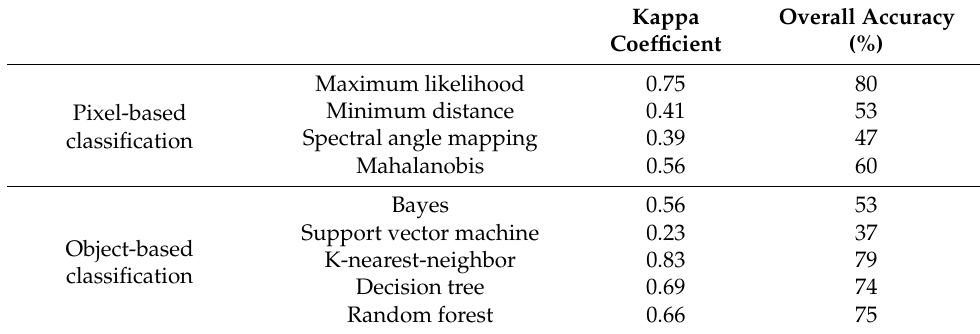
Table 3. Accuracy of classification of Google Earth images using pixel-based and object-based methods.